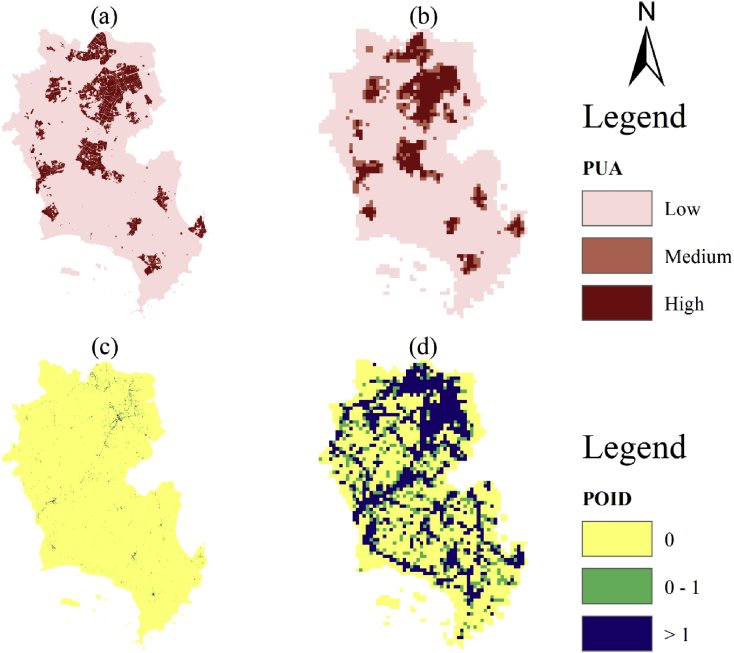
PUA and POID at different resolutions. (a) and (c) are at R30m, (b) and (d) are at R500m.